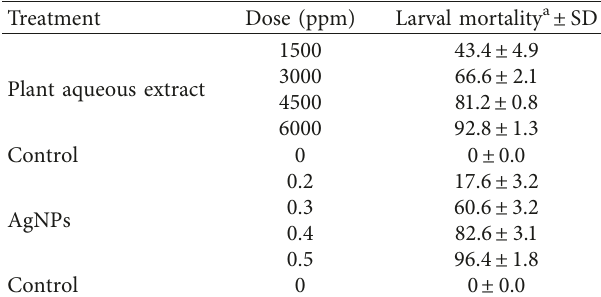
Figure 5: SEM micrograph (a) and EDX spectrum (b) of silver nanoparticles- A. arborescens extract. Table 1: Larvicidal activity of aqueous extracts and silver nano- particles synthesized using Ambrosia arborescens against Aedes aegypti third instar